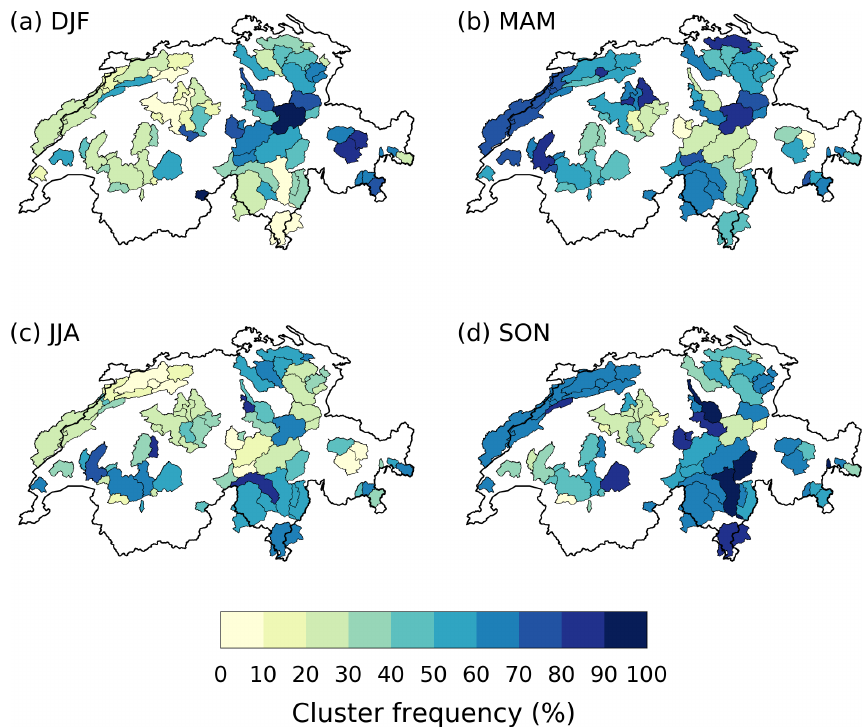
Figure A6. Frequency of extreme precipitation cluster occurrence during extreme 21d cumulative precipitation events ( > 99th percentile) in RhiresD, in (a) DJF, (b) MAM, (c) JJA and (d) SON, for the 63-catchment partition. Compare with Fig.